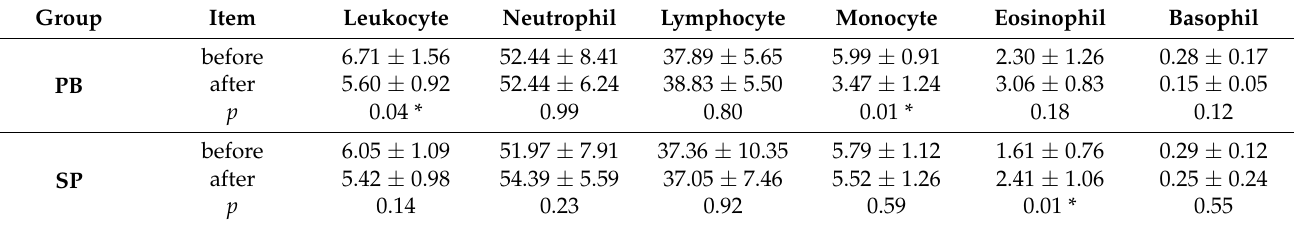
Table 4. A comparison of immune cells ratios within groups.